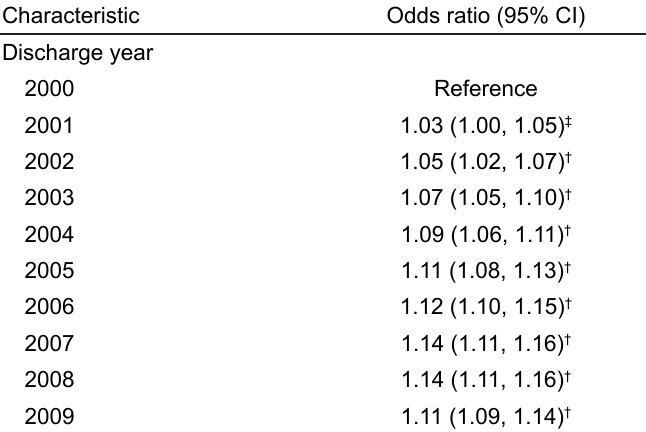
Prolonged acute mechanical ventilation (PAMV):